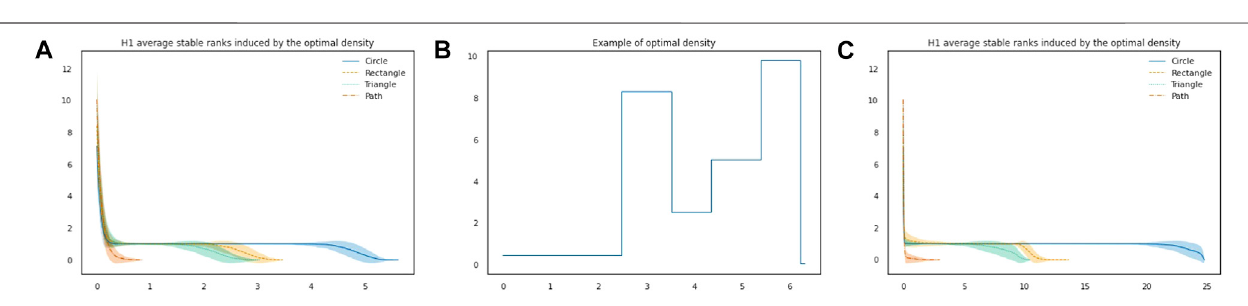
FIGURE 4 | (A) : Average 1-st homology standard stable ranks for each shape (shaded area: standard deviation). (B) : Example of a density considered optimal during one run of the procedure. (C) : Average 1-st homology stable ranks with respect to the optimal pseudometric for each shape (shaded area: standard deviation).